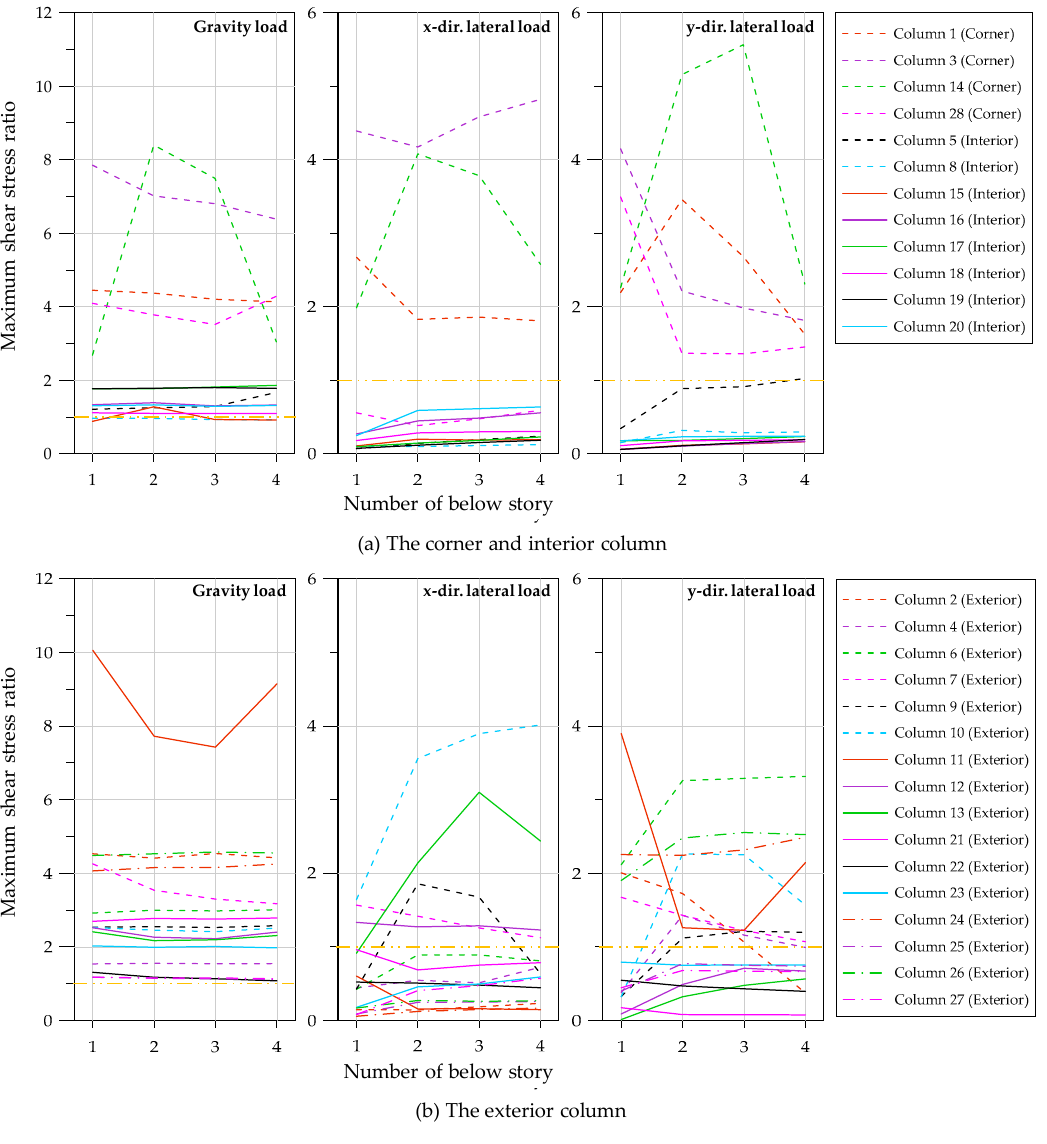
Figure 19. Maximum shear stress ratio vs. number of stories below (L-shape plan). ( a ) Corner and interior columns and ( b ) Exterior